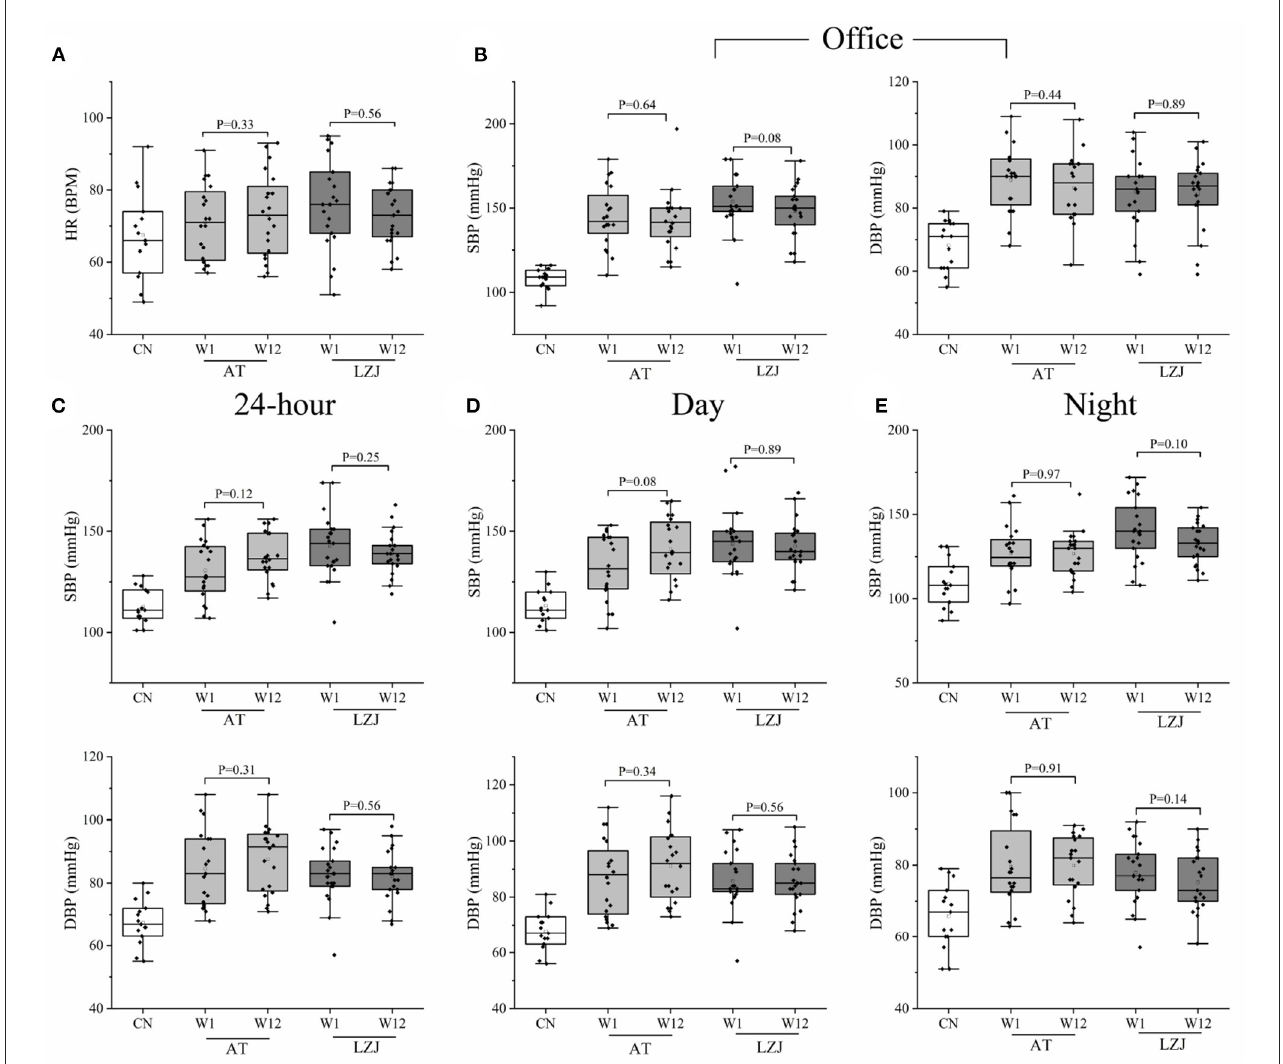
FIGURE2 Changes in clinical indicators between W1 and W12. (A) HR changes after the intervention; (B) Changes in-office blood pressure after the intervention; (C–E) Changes in ambulatory blood pressure after the intervention. The line within the boxplot indicates the median. Whiskers are drawn to a minimum and maximum values, but not further than 1.5 × IQR. Differences in exercise intervention for 12-week changes from baseline of laboratory indexes were tested by analysis of t -test or Mann-Whitney- U test based on whether the data were normally